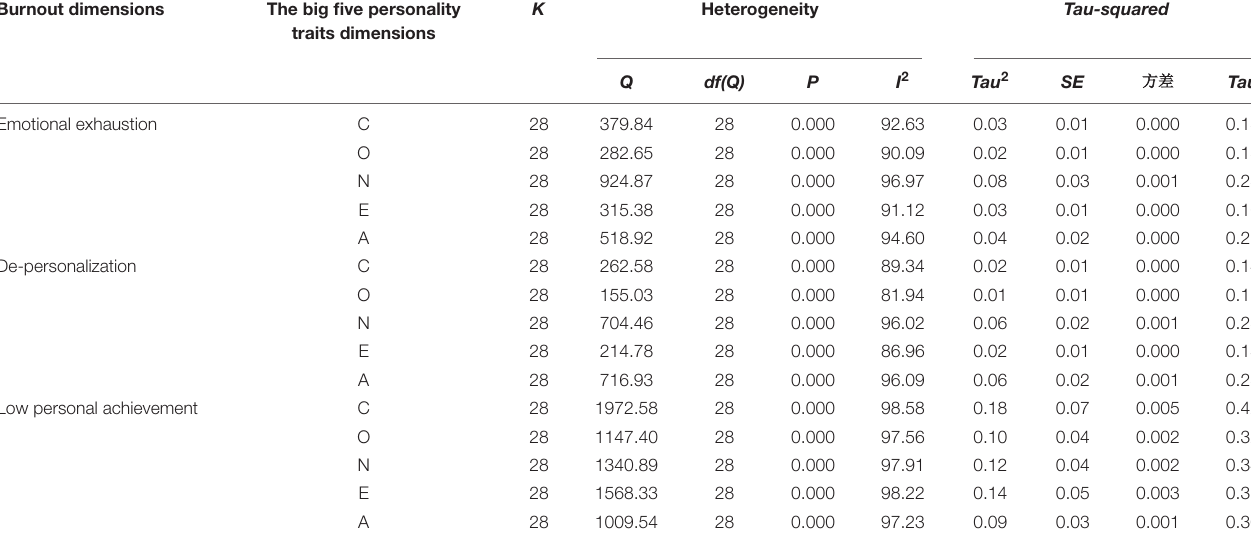
TABLE 2 | Heterogeneity test.